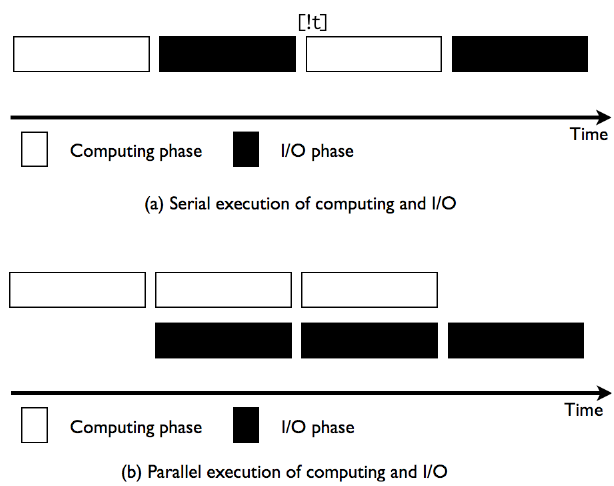
Fig. 1. Overlapping I/O with